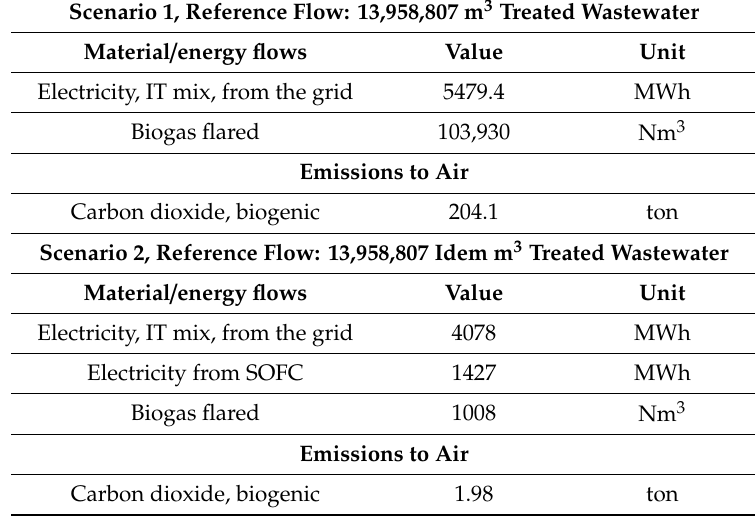
Table 11. The operational phase of the WWTP (primary data from data collection at the WWTP